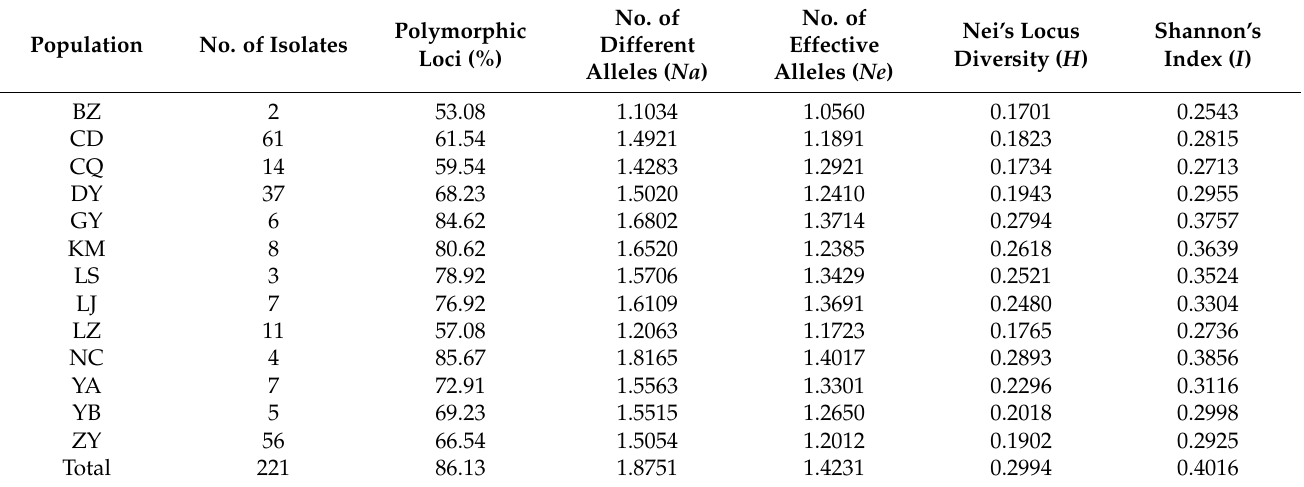
Table 4. Genetic diversity of isolates from different fields in southwest